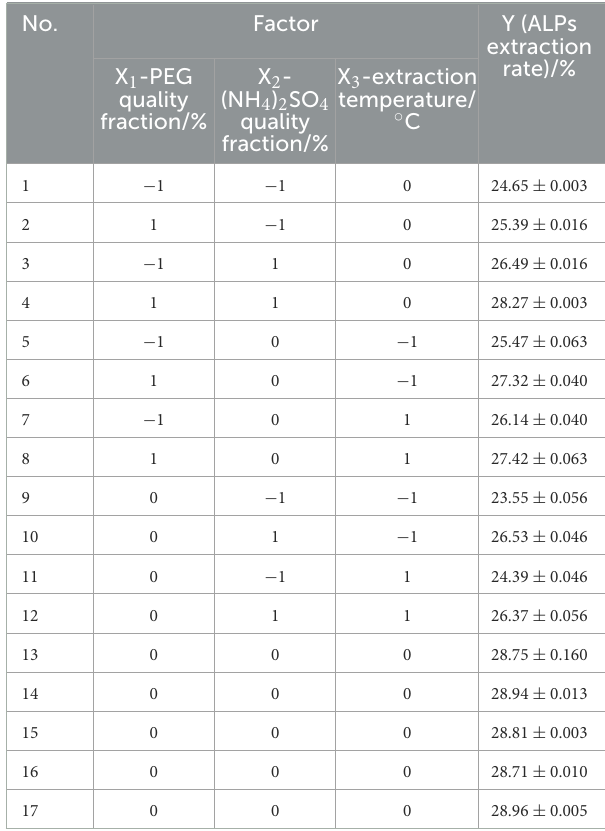
TABLE 2 Box–Benkhen design of the independent variables and experimental values of ALPs